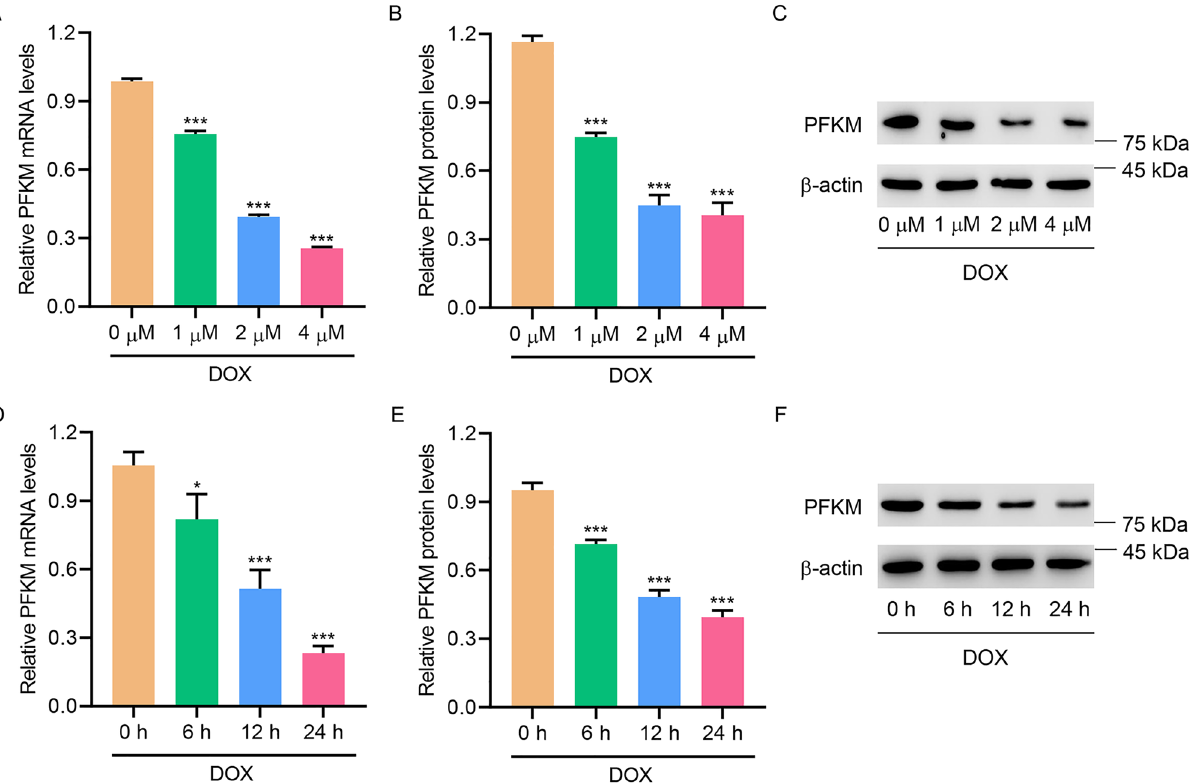
Figure 1. DOX treatment inhibited PFKM expression in H9c2 cells. ( A – C ) PFKM expression in DOX-treated H9c2 cells. ( D – F ) PFKM expression in DOX-treated H9c2 cells for different time points. *P < 0.05, ***P < 0.001 vs 0 μM or 0 h. (see Supplementary Fig.